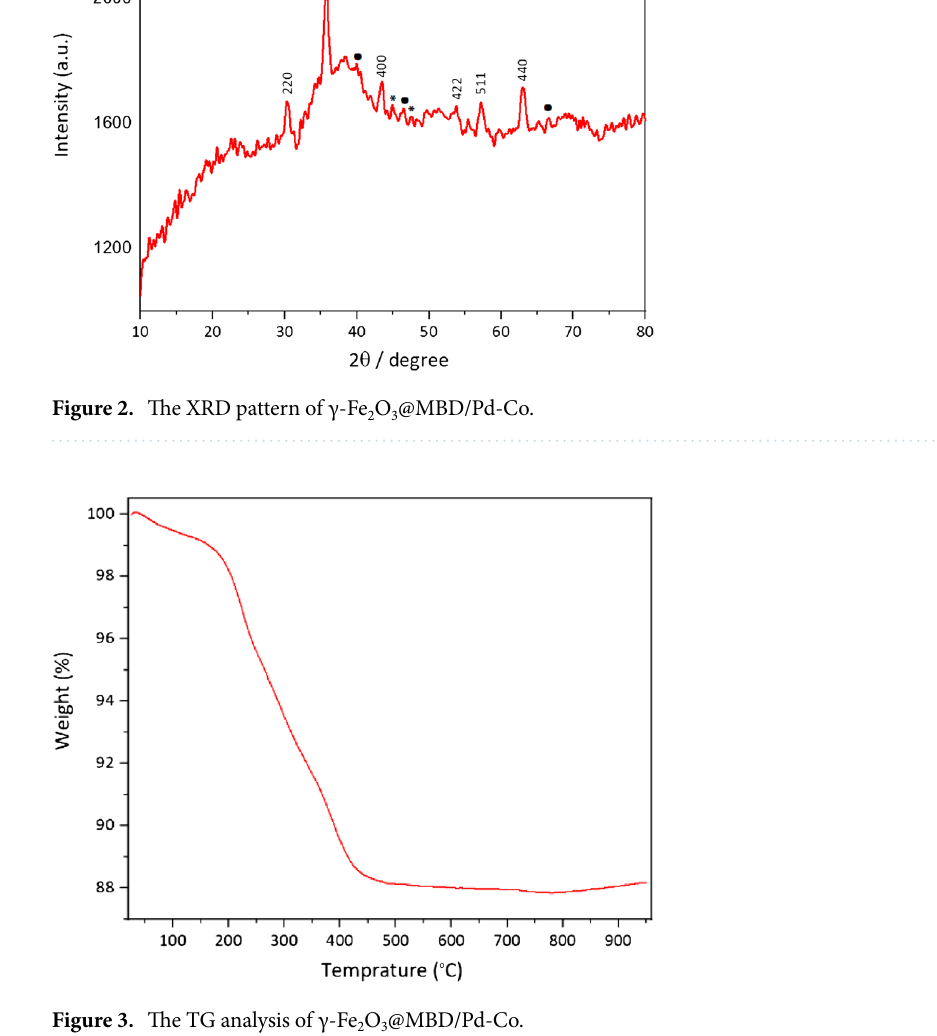
Figure 3. The TG analysis of γ-Fe 2 O 3